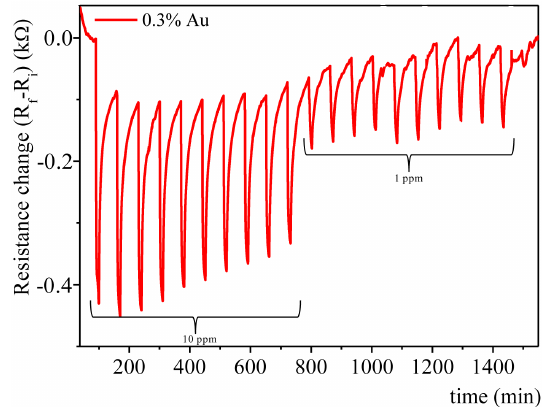
Figure 6. Calibration curves for pristine and Au-decorated CNT-based sensors toward NO 2 gas at 150 ◦ C (a) in the concentration range of 0.1–10ppm and (b) the magnification of 0.1–1.0ppm concentration range.